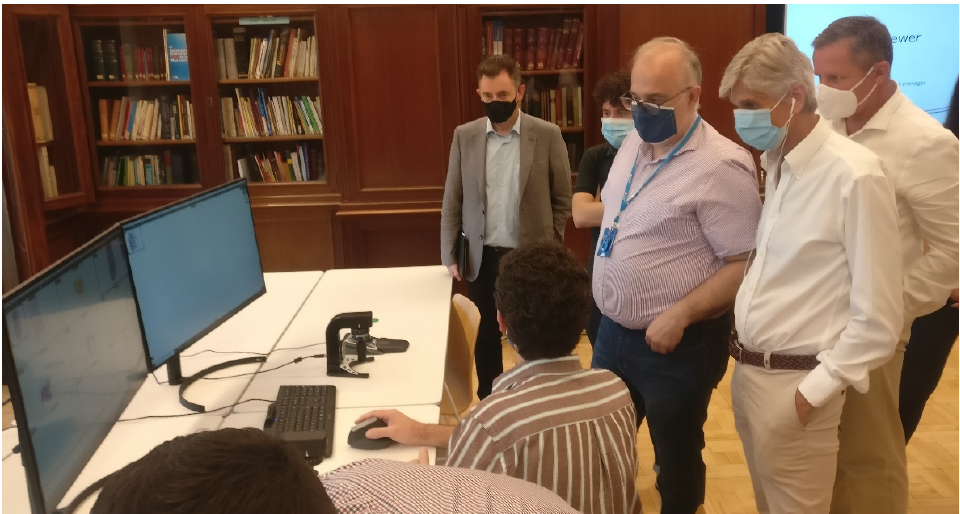
Figure 3. Testing room for tests 2–3, showing from left to right, Miquel Arrufat (ICS), Ramon Bosch (ICS), Pablo López-García (ICS), Josep Maria Argimon (ICS), and Tamás Regényi (3DHISTECH) with the Palex 3DHISTECH equipment (LG 32HL512D 8MP Diagnostic Monitor, Logitech MX Vertical Ergonomic Wireless Mouse, and 3DHISTECH SlideDriver).